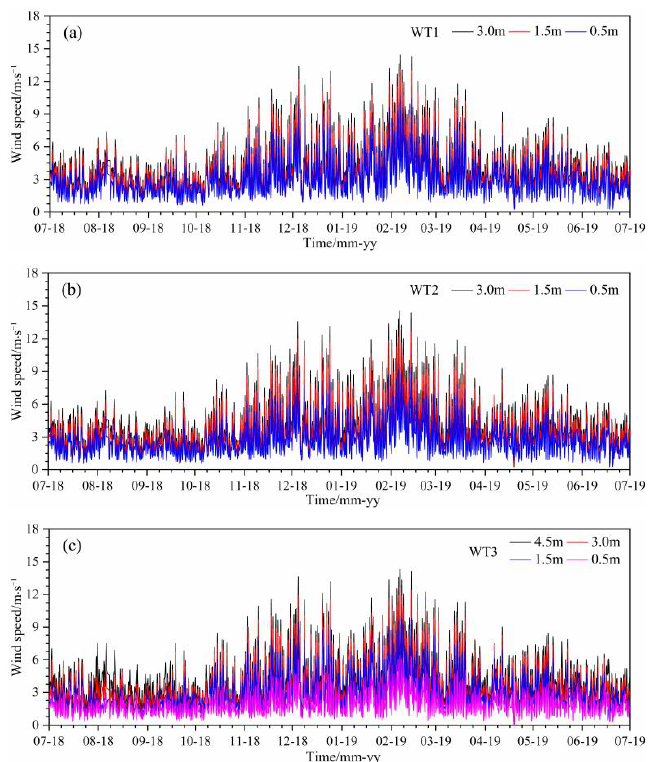
Figure 3. Variations in the wind speed at different heights of the three wind-towers from July 2018 to July 2019: ( a ) WT1 with the heights of 0.5, 1.5, and 3.0 m above the ground; ( b ) WT2 with the heights of 0.5, 1.5, and 3.0 m above the ground; and ( c ) WT3 with the heights of 0.5, 1.5, 3.0, and 4.5 m above the ground.